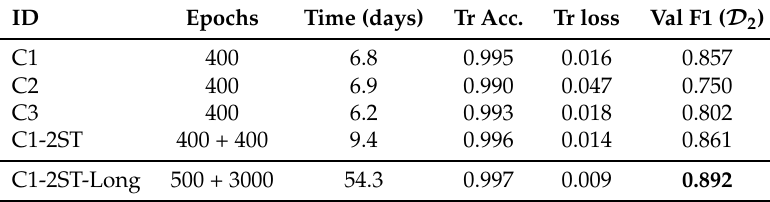
Table 6. Validation performance obtained on D 2 using the three best configurations C1, C2, and C3, the two-step training (2ST) strategy with configuration C1, and a long training of 3000 epochs (Long). We also report the training time, the accuracy, and loss achieved on the training